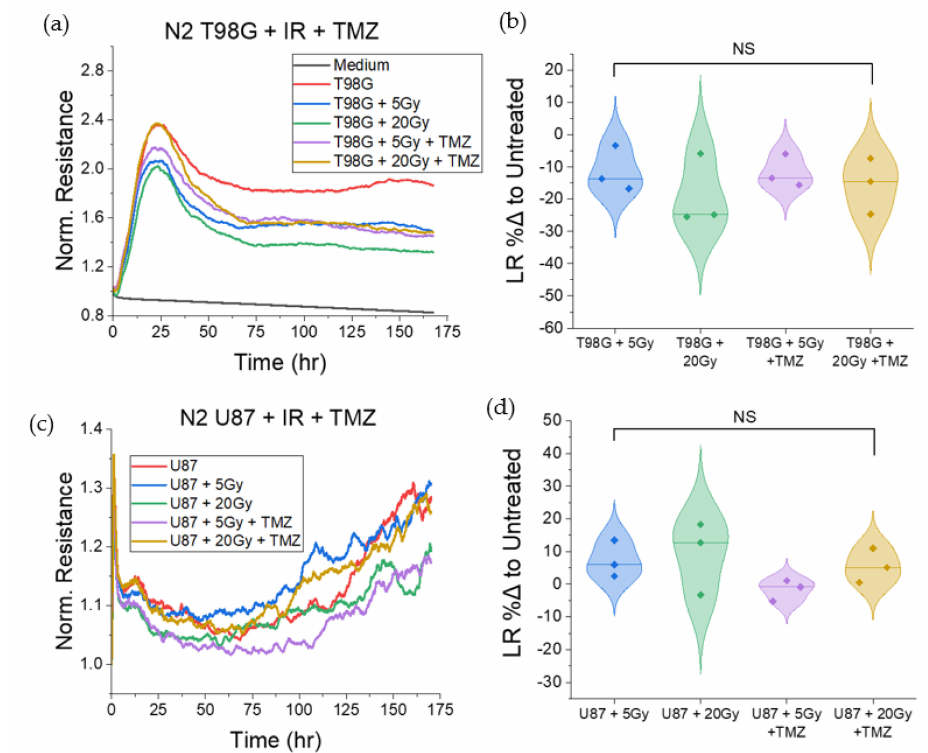
Figure 6. Late resistance (LR) results. ( a ) Plots of the normalized resistance over 1 week post- treatment for T98G. ( b ) Violin plots of percent difference comparisons of late resistance for treated conditions in ( a ) relative to the untreated condition. ( c ) Plots of the normalized resistance over 1 week post-treatment for U87. ( d ) Violin plots of percent difference comparisons of late resistance for treated conditions in ( a ) relative to the untreated condition. Though marginal changes can be seen in ( b , d ), there were no statistically significant changes to LR for either cell line treated with radiation alone or with concurrent temozolomide. NS